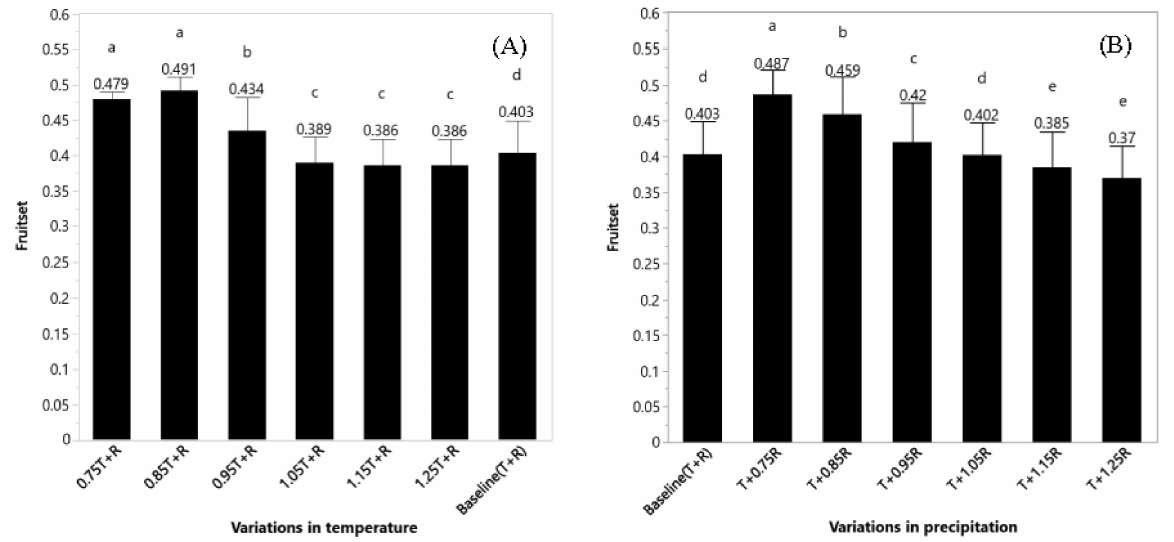
Figure 8. Effects of change in air temperature ( A ) or precipitation ( B ) on bog blueberry’s fruit-set in the 151 growing regions in Northeast China. Error bars are one standard deviation of the mean. Different letters on bars indicate significant differences ( α = 0.05) between climate change